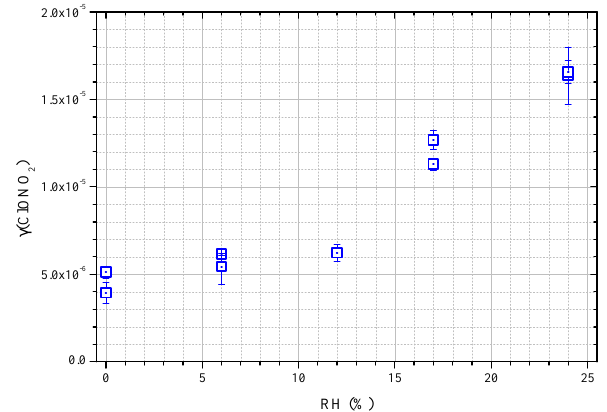
Figure 5. Dependence of γ (ClONO 2 ) on RH for Pyrex